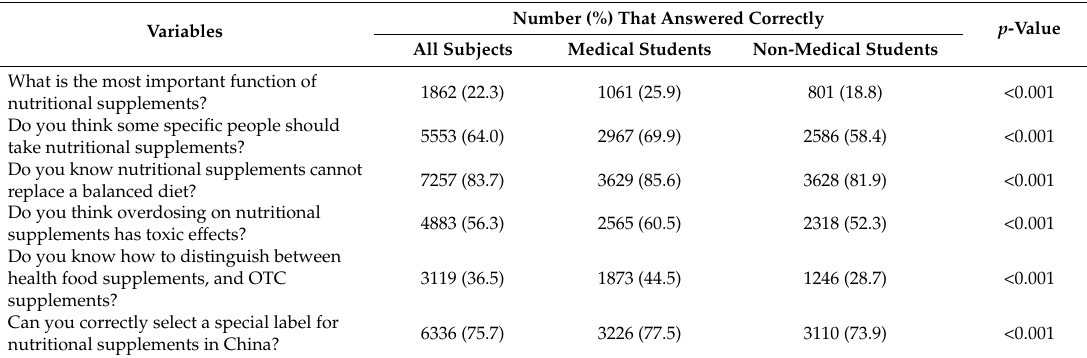
Table 4. Knowledge on nutritional supplements by Chinese students.